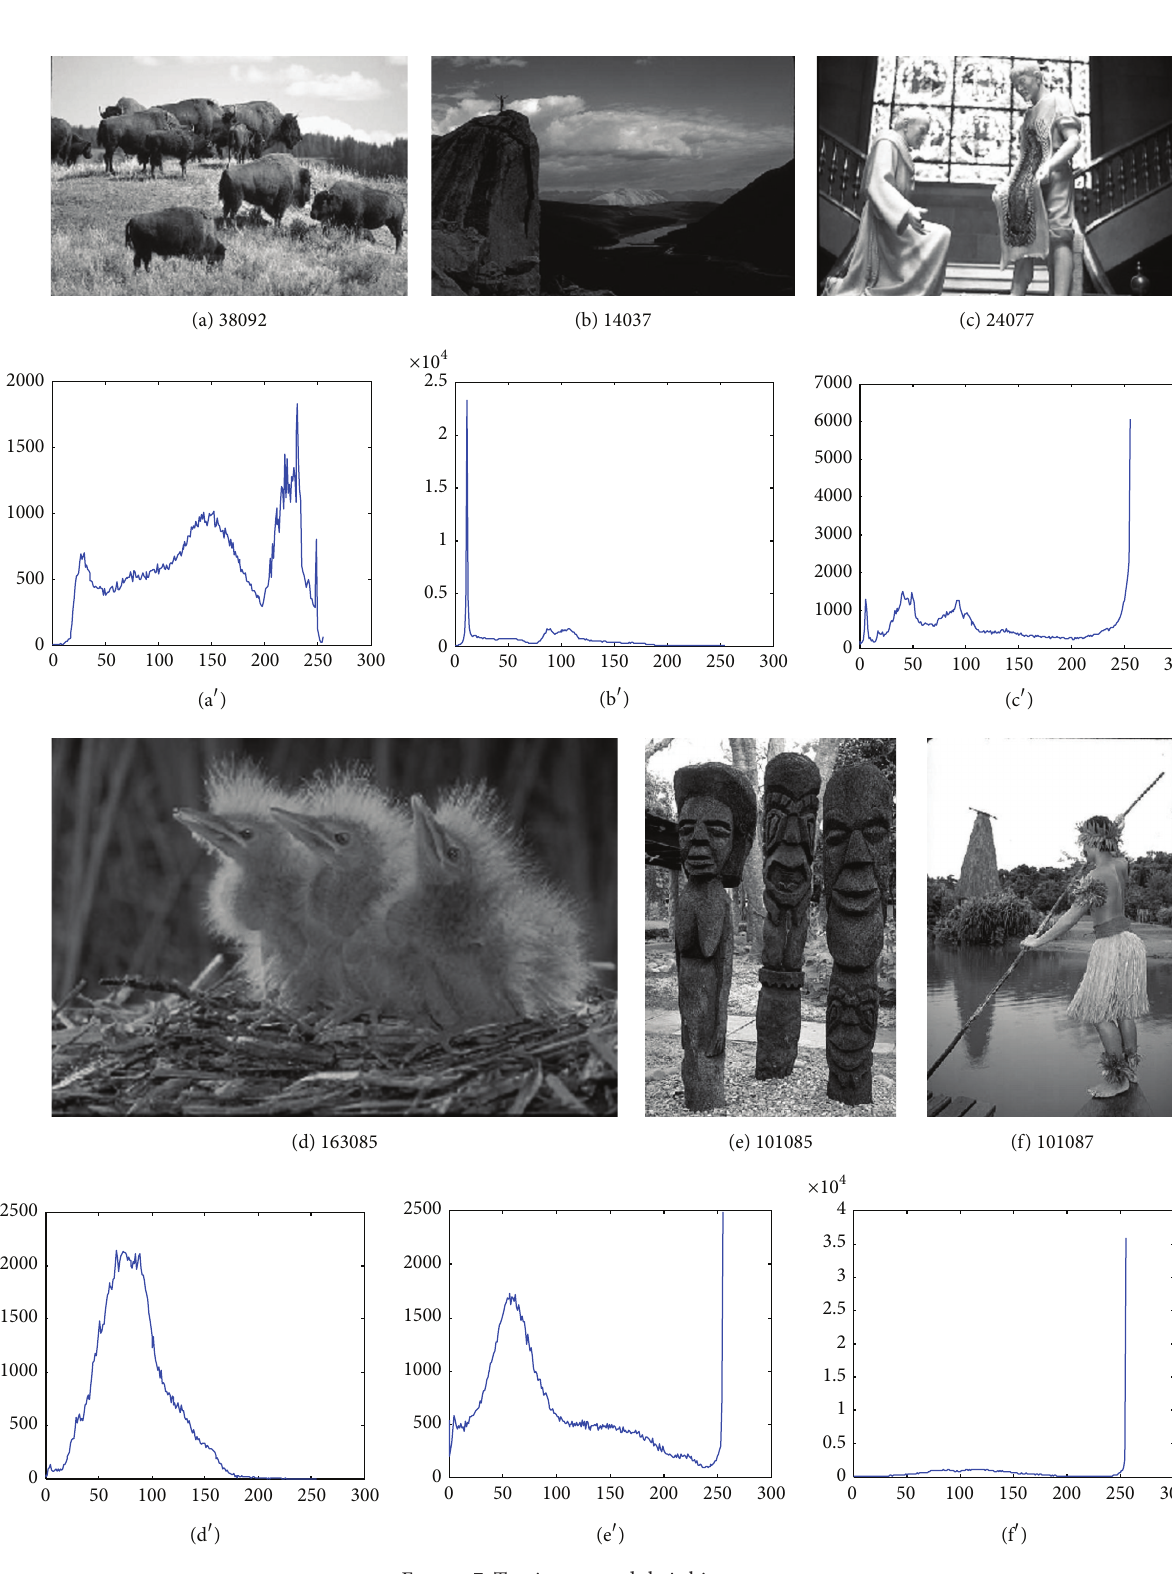
Figure 7: Test images and their